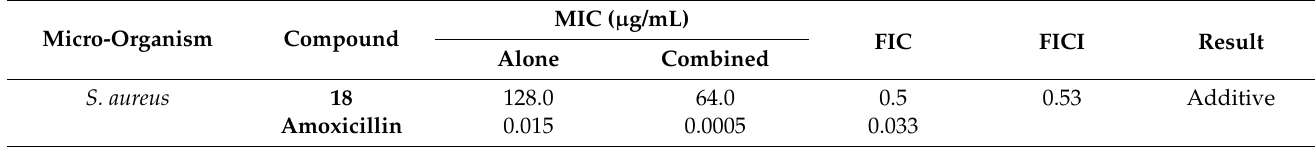
Table 8. Synergistic effect of compound 18 with amoxicillin against S. aureus